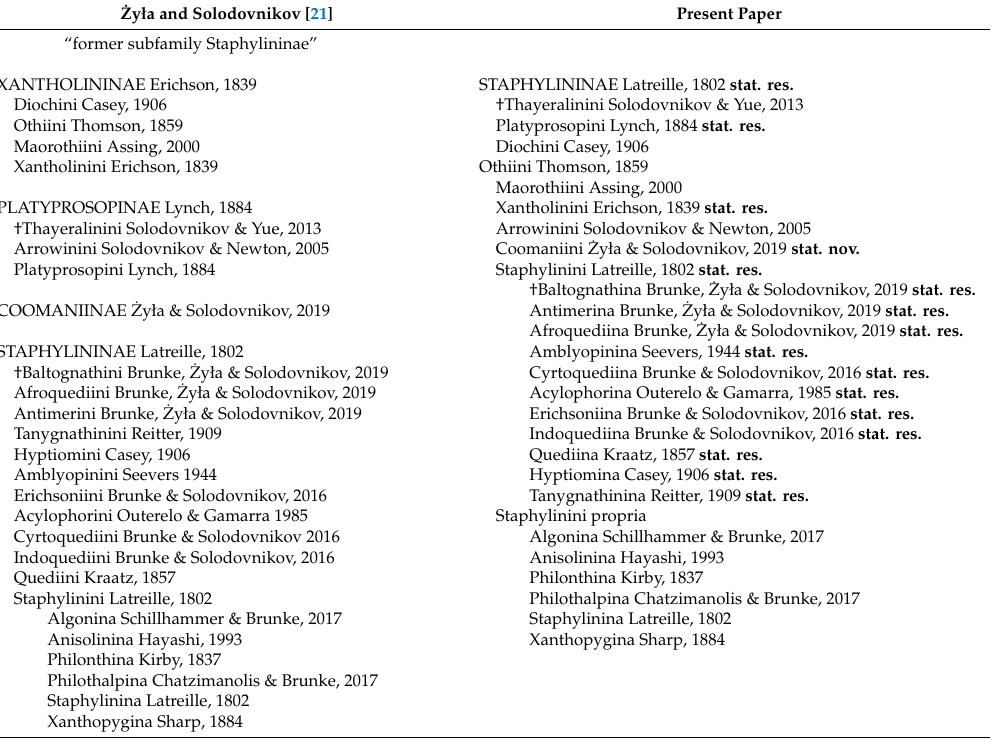
Table 1. Comparison of the classification schemes of Staphylininae of ˙Zyła and Solodovnikov [21] and the revised scheme proposed